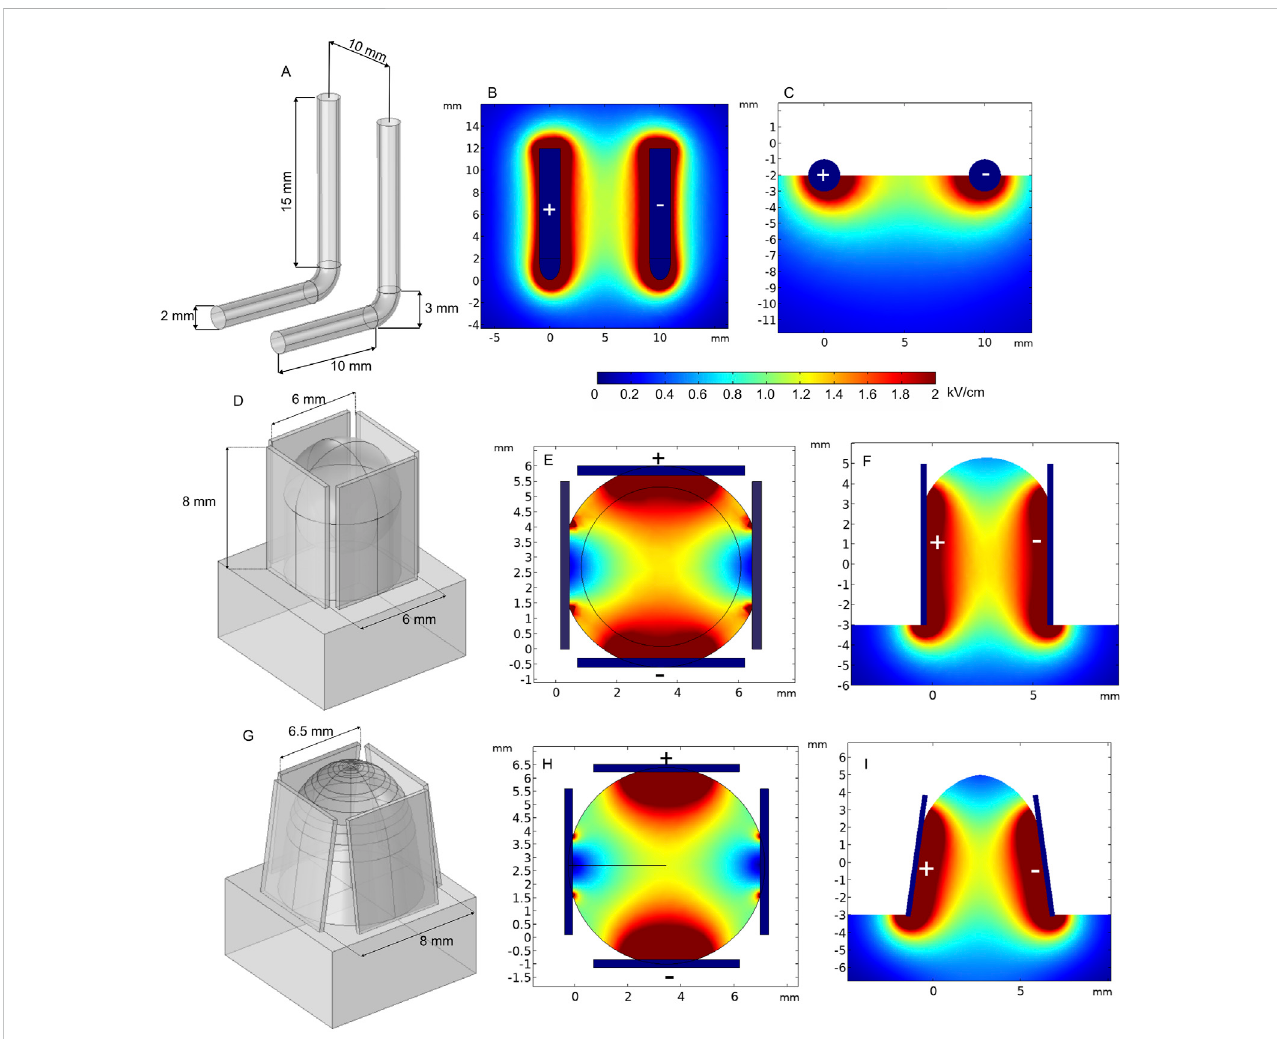
FIGURE 11 L-shaped (A – B) and 4-plate electrodeswith (D – F) and without expansion (G – I) when1300 V terminal voltage isused. (A) L-shaped electrodestructure; (B) spatialelectric fi elddistribution,topview; (C) spatialelectric fi elddistribution,sideview; (D) 4 – plateelectrodestructurewithoutplateexpansion; (E) spatial electric fi eld distribution without plate expansion, top view; (F) spatial electric fi eld distribution without plate expansion, side view; (G) 4-plate electrode structure with plate expansion; (H) spatial electric fi eld distribution with plate expansion by 8 ° , top view; (I) spatial electric fi eld distribution without plate expansion by 8 ° , side